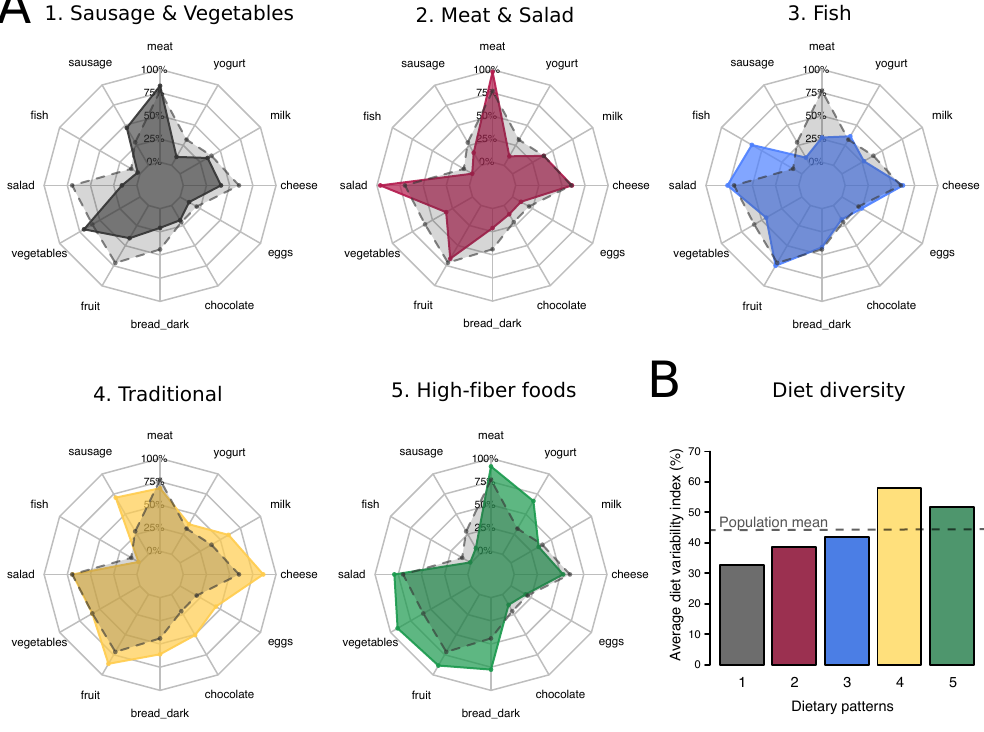
Figure 1. Dietary patterns of the Swiss Population (1977–1993; N = 15,936). ( A ) Percentage of individuals assigned to a dietary pattern who reported the consumption of the food groups. Grey dashed lines represent the percentage of individuals consuming the 12 food groups in the total study sample. Order of the dietary patterns is random and names were given based on food group consumption; ( B ) Average dietary variety (%) in individuals following each dietary pattern. Dietary variety is calculated for each participant as the number of food groups consumed divided by the total number of food groups in the diet checklist (12 food groups). Horizontal dashed line indicates the average dietary variety of the total study